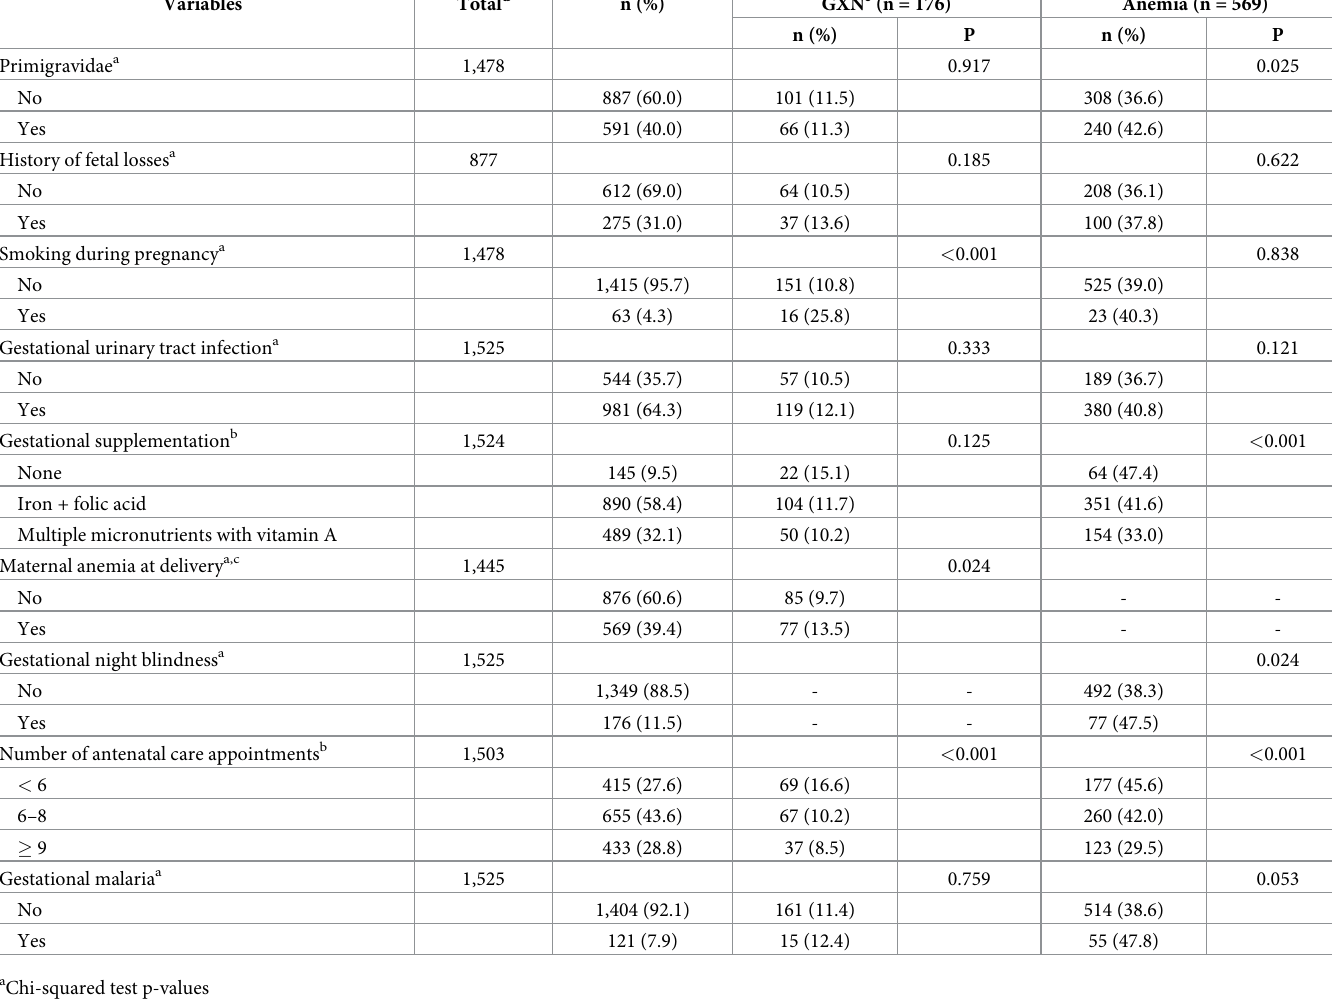
Table 2. Obstetric and gestational characteristics of parturients from the MINA-Brazil study by outcome.